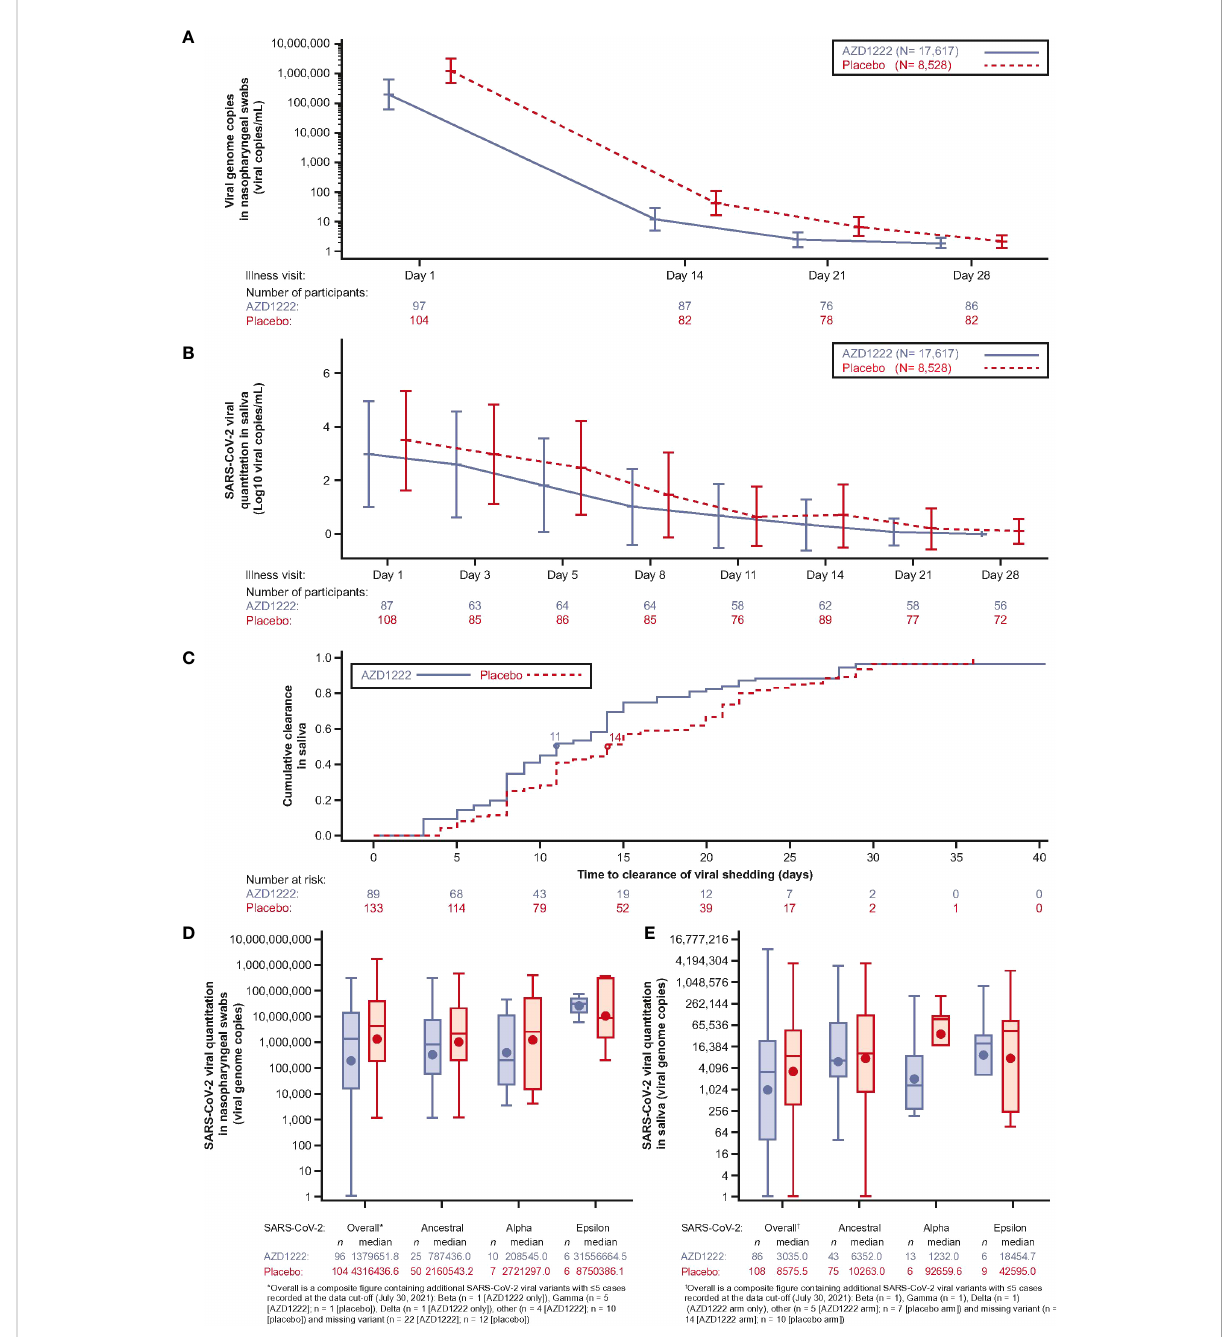
FIGURE 2 Virologic outcomes to breakthrough infection are attenuated in AZD1222 vaccinees compared to unvaccinated. (A) SARS-CoV-2 genome copies from participant nasopharyngeal swabs collected at illness visits determined by quantitative (q)RT-PCR. Line plot with geometric means and 95% CI. Viral genome copies were imputed to 1 when the SARS-CoV-2 nasopharyngeal swab qualitative result was not detected. (B) SARS- CoV-2 quantitation (Log10 viral copies/mL) in participant saliva over time. Line plot with mean ± SD. Not detected values of viral quantitation are treated as 0. (C) Cumulative incidence plot of SARS-CoV-2 clearance (saliva samples). The median time to clearance of viral shedding for each group is marked by a circle. (D, E) Viral load by SARS-CoV-2 variant (viral genome copies) in nasopharyngeal swabs (D) and saliva samples (E) collected at fi rst illness visit determined by qRT-PCR. The bottom and top edges of the box indicate the fi rst and third quartiles, the difference is the IQR, the line inside the box is the median, and the marker inside the box is the geometric mean. The whiskers that extend from the box indicate the minimum and maximum after removing outliers (i.e., datapoints >1.5 x IQR from the box). Viral genome copies are imputed to 1 when the SARS-CoV-2 nasopharyngeal swab qualitative result is not